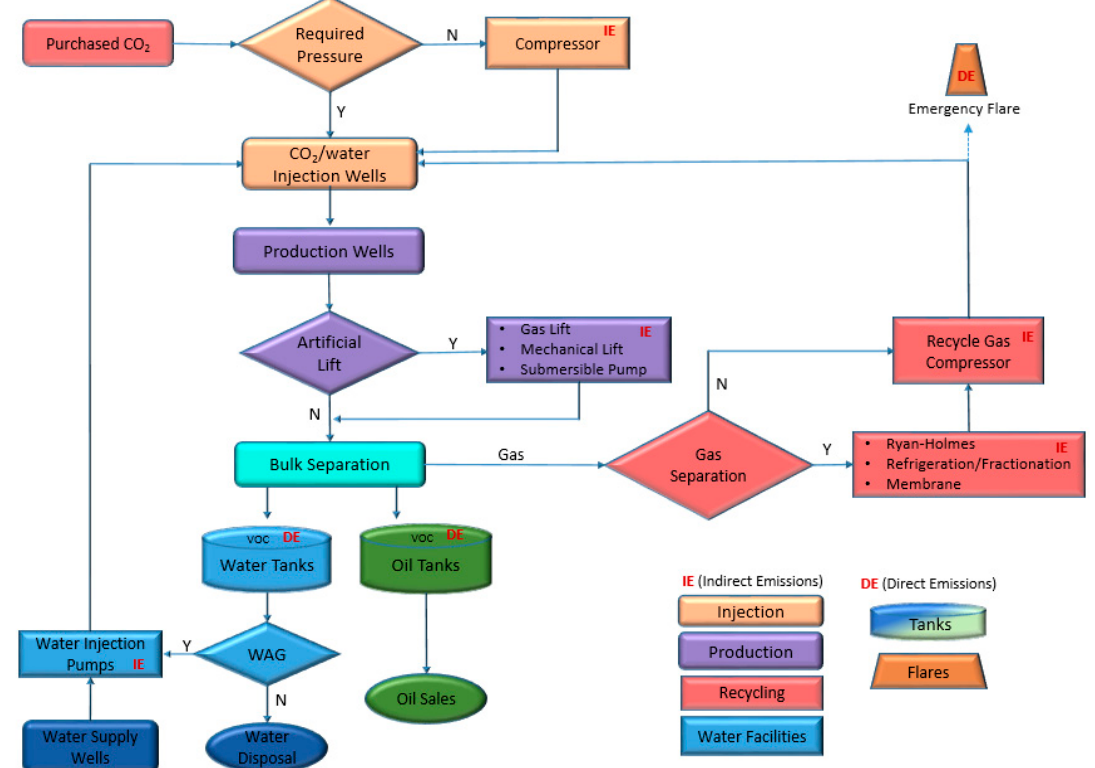
Figure 3. Methodology for direct and indirect CO 2 emissions inventory at the enhanced oil recovery (EOR) site.